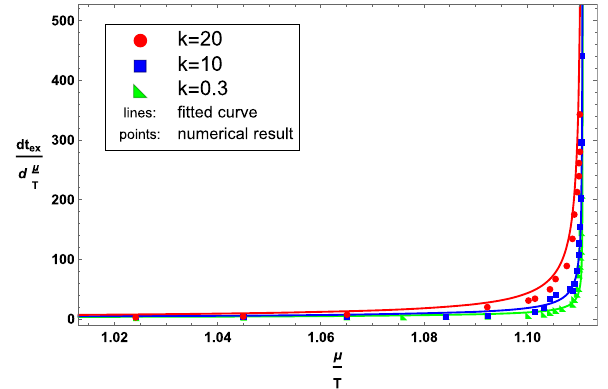
Fig. 7 dt ex as a function of μ . We fixed the values of interquark dis- T d μ T tance l = 0 . 45 and the temperature T = 0 . 31 ( lT = 0 . 14) for all cases while for green points the value of the transition time is k = 0 . 3 and for blue (red) points are k = 10 ( k = 20), respectively. The green curve − μ ) − θ , fitted with the data with θ = 0 . 529178. √ is the function, ( π T 2 2 The blue and red curves are the same functions fitted with the data with θ = 0 . 641450 and θ = 0 . 830707,